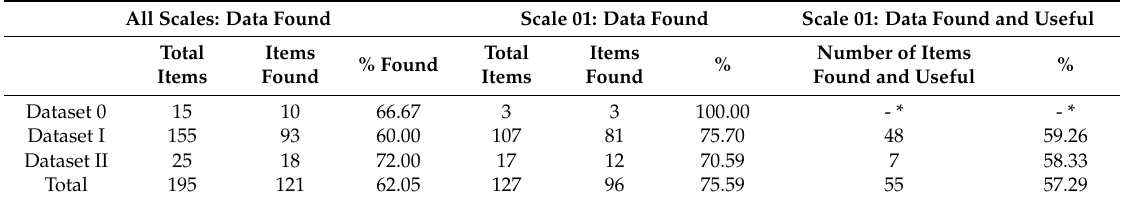
Table 7. Data gathered for all scales, data gathered specifically for Scale 01 and data finally computed into the sustainability assessment: Tepeji pilot site.